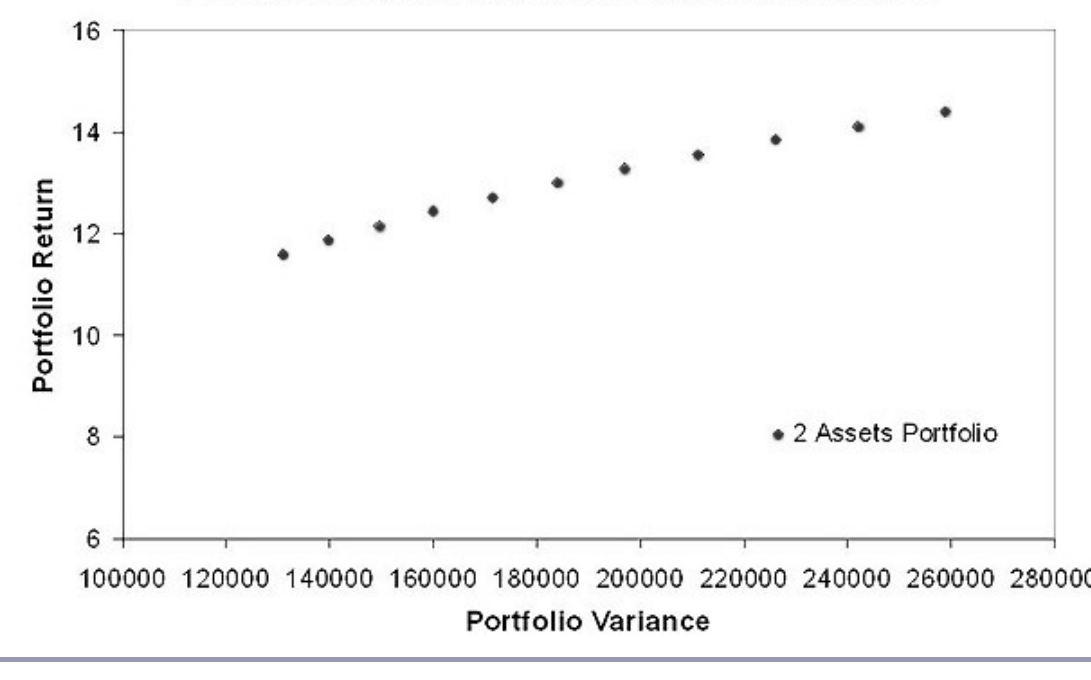
Fig. 5. Portfolio return and variance values for portfolios consisting of two assets (D+ and Cp) under the current climate